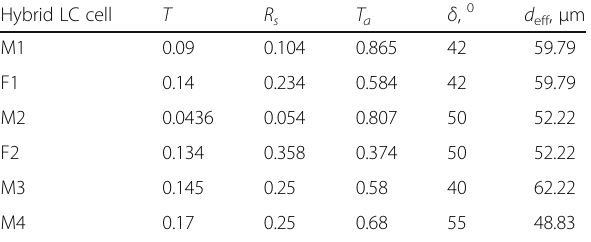
and effective thickness d eff of the cells